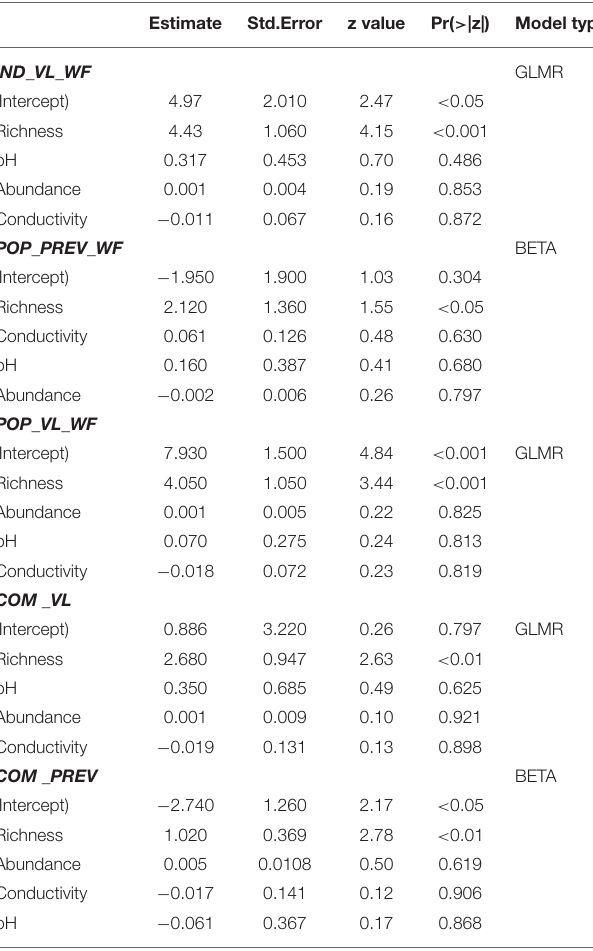
TABLE 5 | Generalized linear mixed model (GLMR) and beta regression (BETA) results for ranavirus prevalence and viral loads in terrestrial amphibian life-stages at the community and population level (wood frog only).